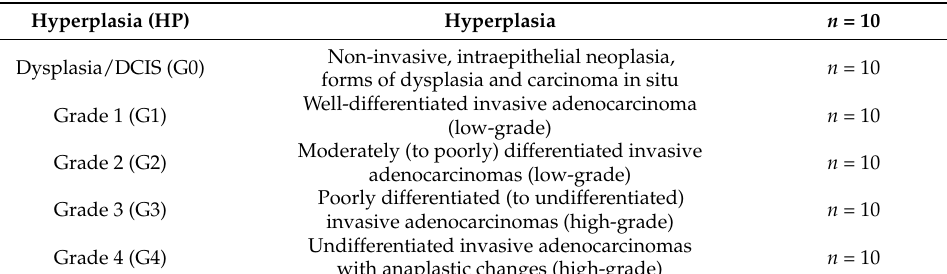
Table 3. Histological grading of the tissue specimen and sections ( n ) per grading. Histological stages of neoplastic transformation and grading of invasive adenocarcinomas of the breast; number of sections ( n = 60).